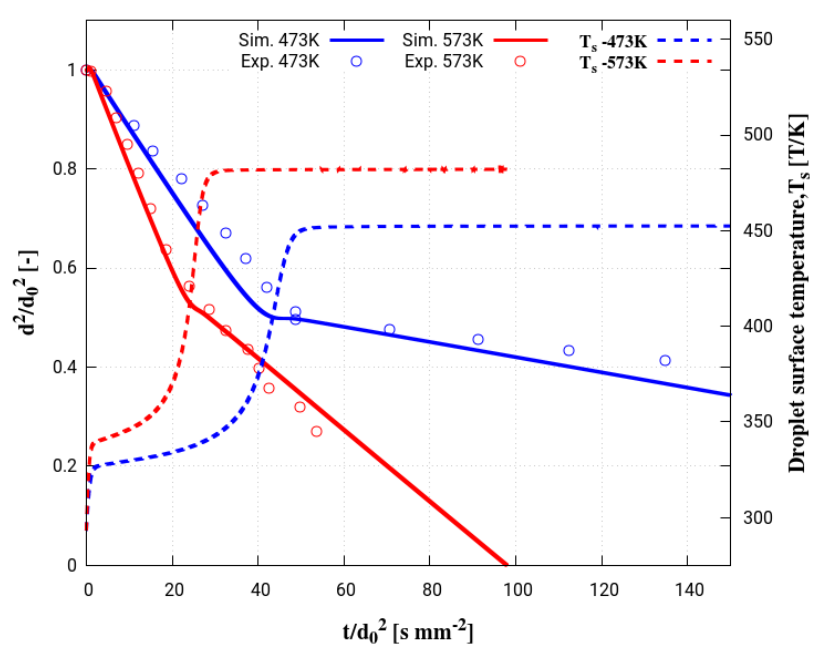
Figure 3. Validation of evaporation model (C05) for AdBlue ® droplet evaporation under gravitational influence (experiment